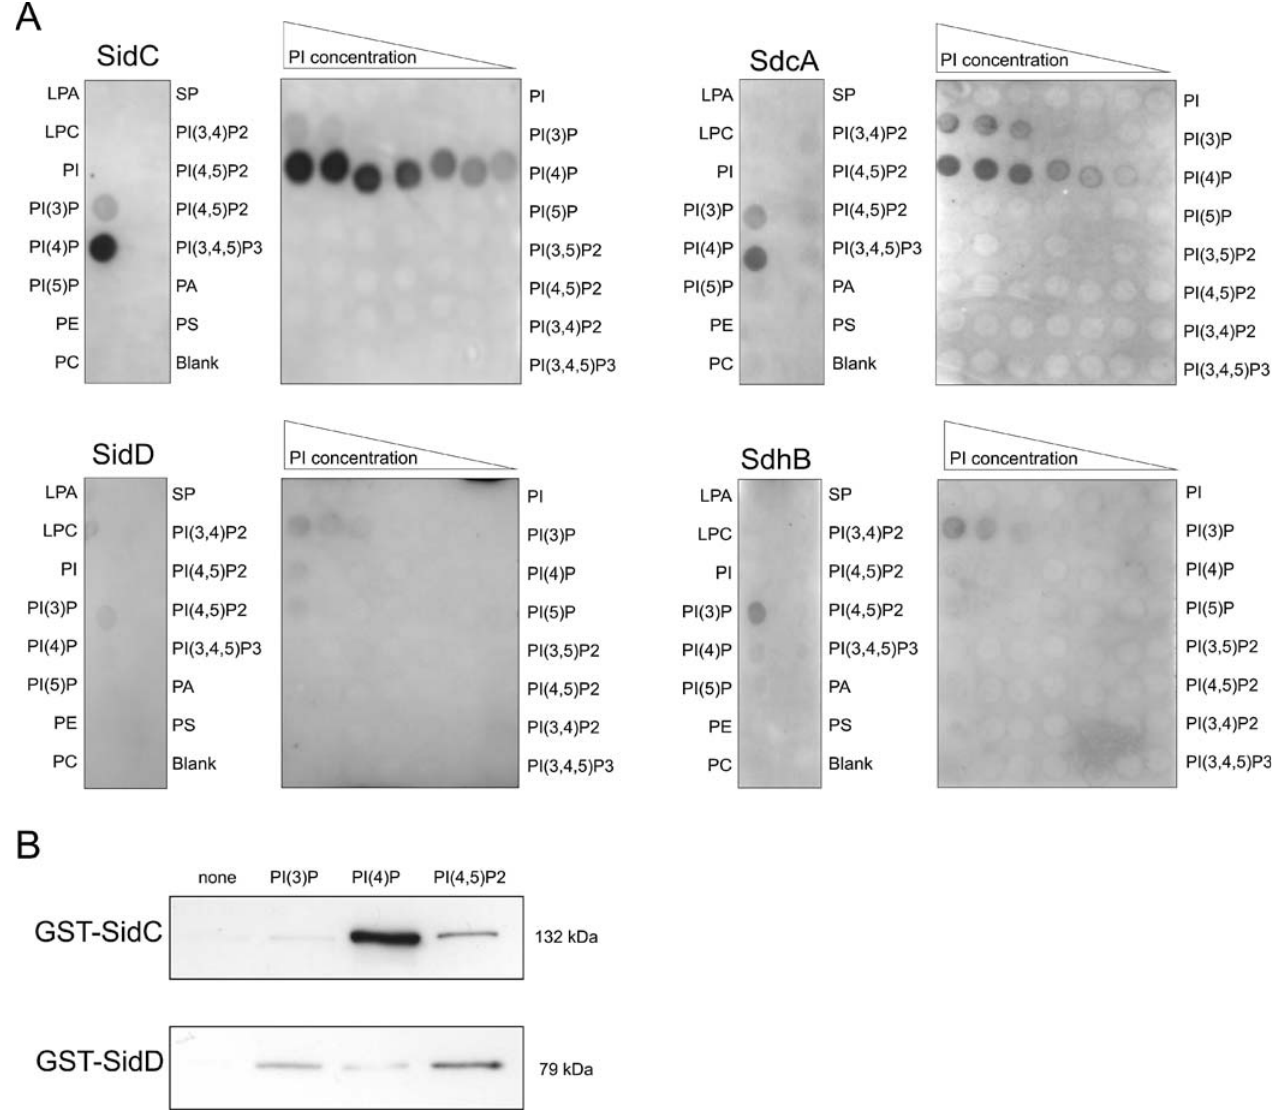
Figure 5. Binding of L. pneumophila Icm/Dot–Secreted Proteins to PIs In Vitro (A) Binding of affinity-purified GST fusion proteins of SidC, SdcA, SidD, or SdhB (160 pmol) to different lipids (100 pmol; left panels) or 2-fold serial dilutions of PIs (100–1.56 pmol; right panels) immobilized on nitrocellulose membranes was analyzed by a protein-lipid overlay assay using an anti-GST antibody. Lysophosphatidic acid is denoted by LPA; lysophosphocholine is denoted by LPC; sphingosine-1-phosphate is denoted by SP; phosphatidic acid is denoted by PA; and phosphatidylserine is denoted by PS. The experiment was reproduced at least three times with similar results. (B) PL vesicles (20 l l, 1 mM lipid) composed of PC (65%), PE (30%), and 5% (1 nmol) either PI(4)P, PI(3)P or PI(4,5)P 2 were incubated with affinity-purified GST-SidC or GST-SidD (40 pmol), centrifuged, and washed. Binding of GST fusion proteins to PL vesicles was assayed by Western blot with an